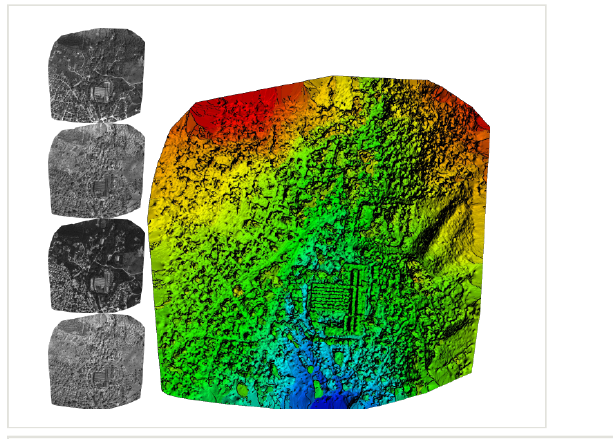
Figure 11. Digital Surface Model of the area of ‘Suchurum’ waterfall in Karlovo.